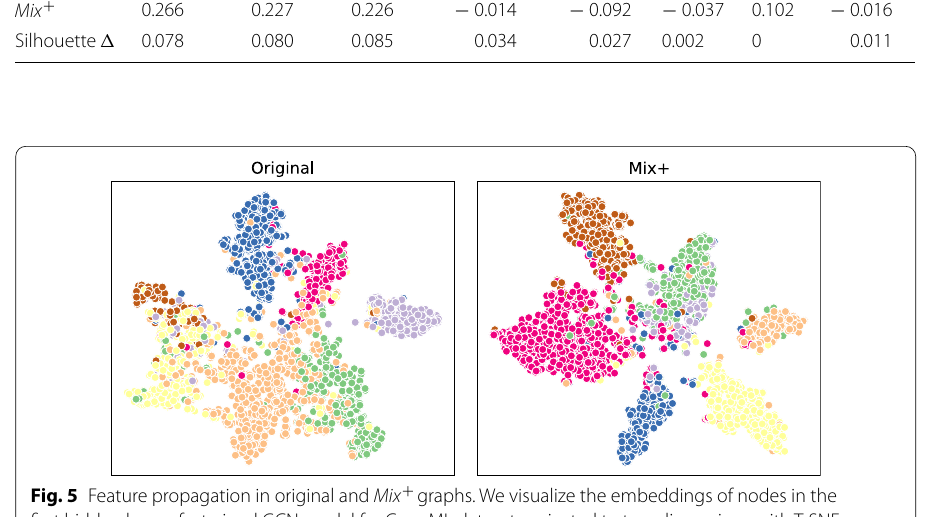
Fig. 5 Feature propagation in original and Mix + graphs. We visualize the embeddings of nodes in the first hidden layer of a trained GCN model for Cora-ML dataset projected to two dimensions with T-SNE. The embeddings in the original graph (on the left) show an overlap of the areas of different labels. The embeddings in the Mix + graph (on the right) show less overlap and are more linearly separable already in the first layer. As a result, we see an increase of the performance with Mix +